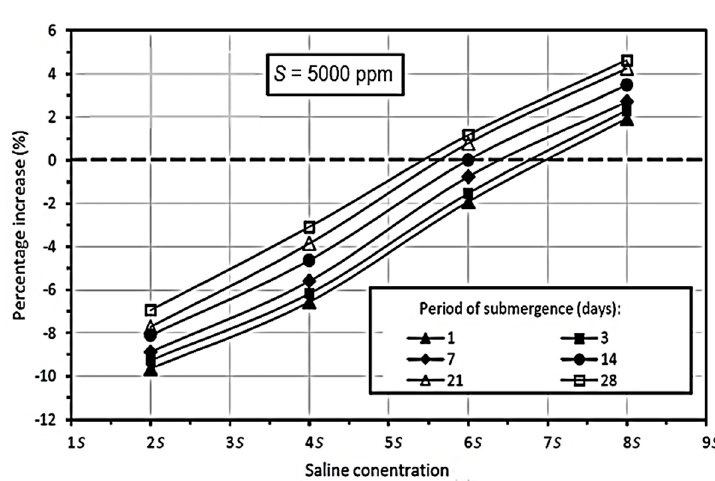
Figure 6. Variation of percentage increase in the value of G with saline concentration.